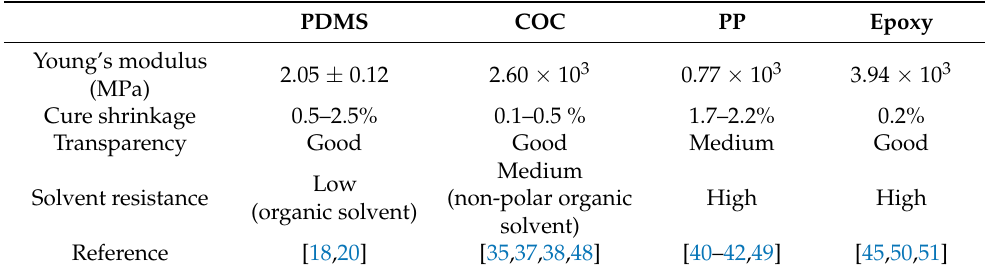
Table 1. Physical properties of polymer for microchannel